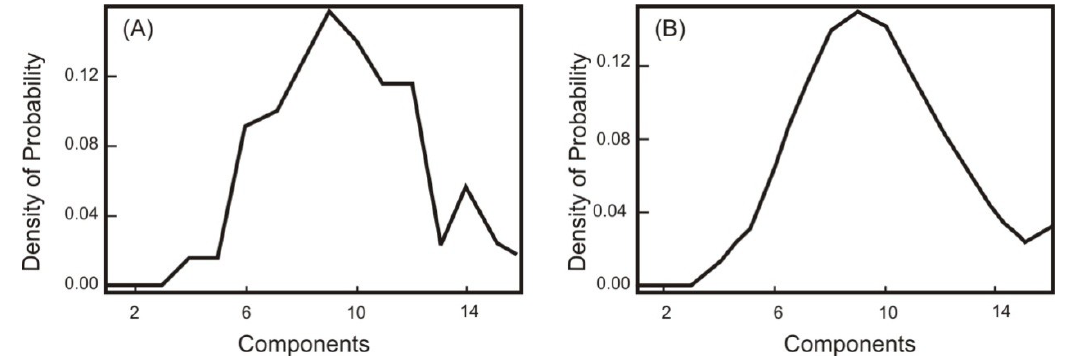
Figure 9. Noise treatment of the PDC by the use of inverse NAPC rotation: ( A ) original data and ( B ) result after denoise processing.